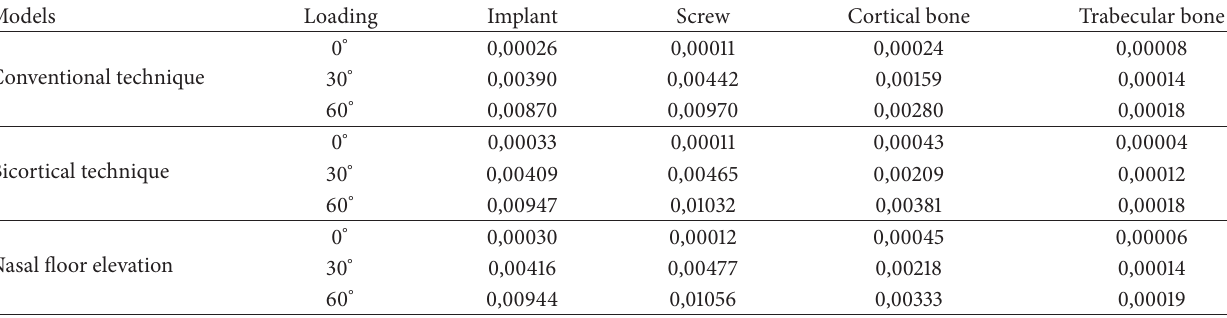
Table 3: Solid mesh convergence error.